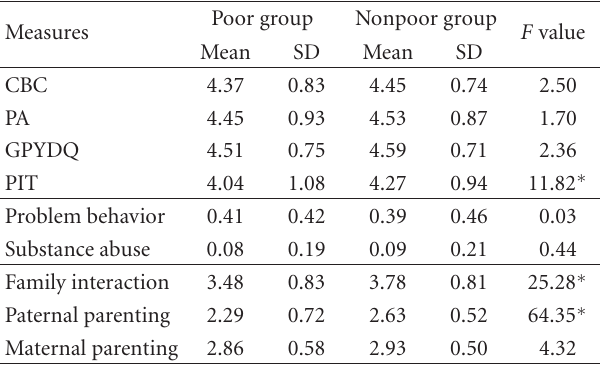
Table 4: Di ff erences between poor group and nonpoor group in positive youth development